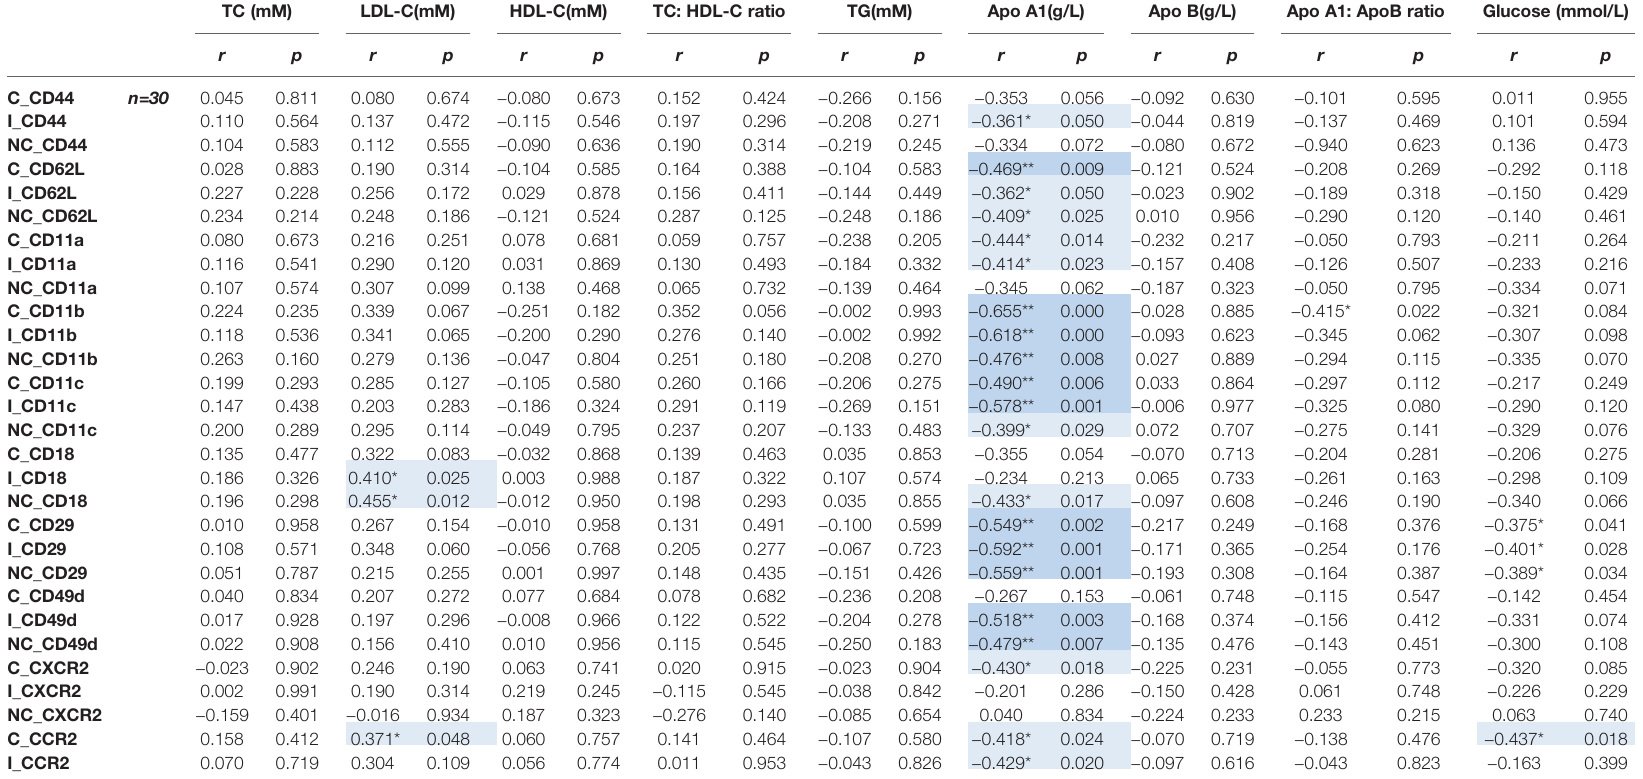
TABLE 2 | Recruitment marker expression relative to lipid levels for each monocyte